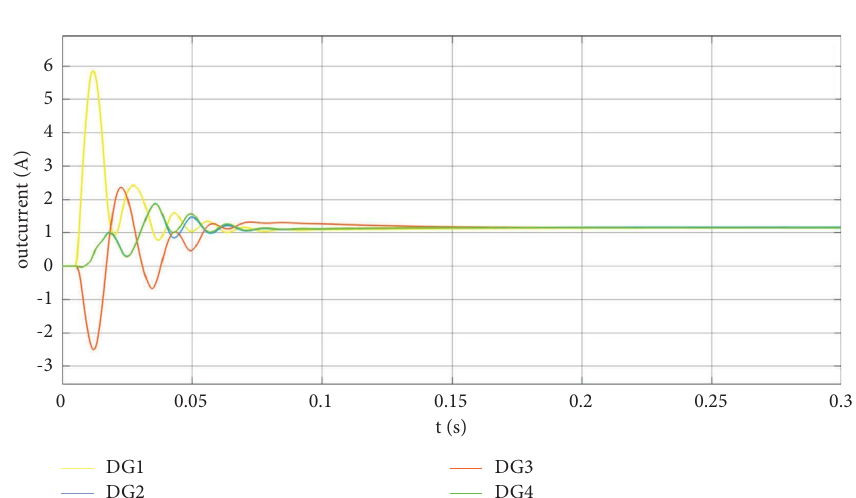
Figure 6: Output current considering input delay.